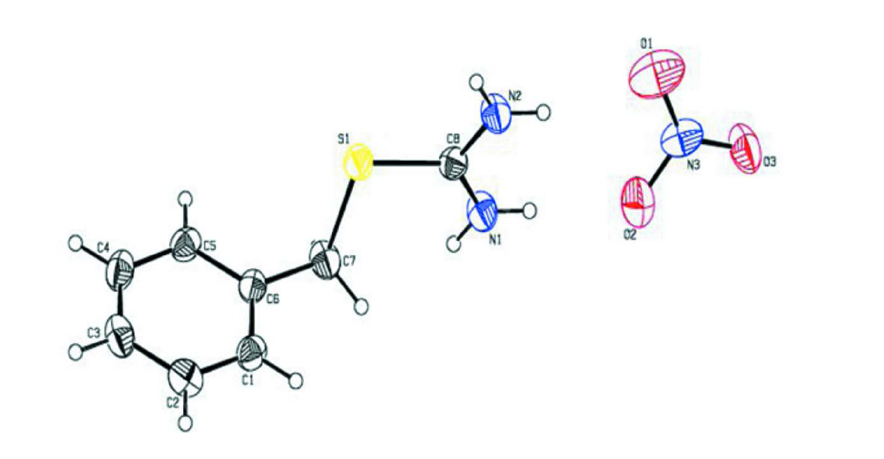
Figure 1 The molecular structure of title compound, showing 30% probability displacement ellipsoids.